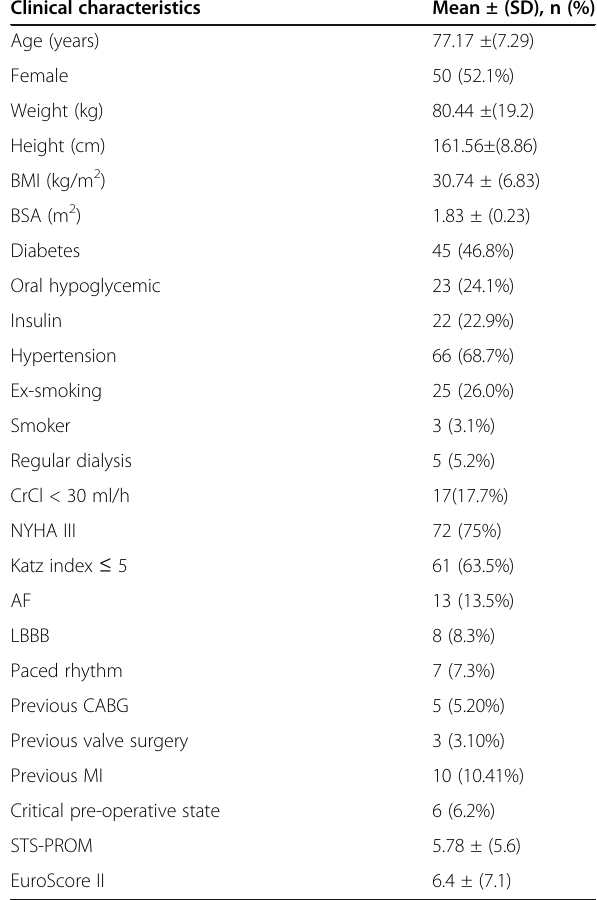
Table 1 Baseline characteristics Clinical characteristics